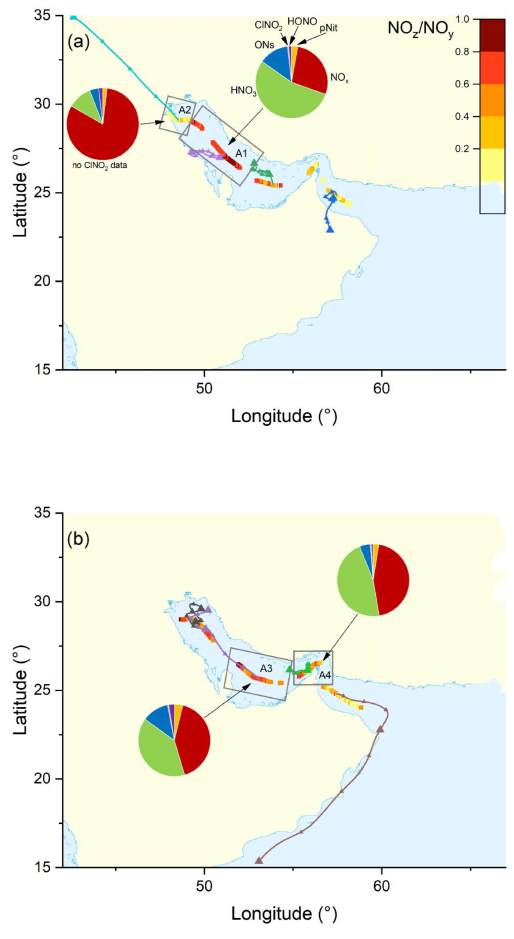
Figure 11. The NO z / NO y ratio over the Arabian Gulf during the (a) first and (b) second legs. Coloured lines are 2d back-trajectories (HYSPLIT). The pie charts indicate the components of NO y at various segments along the ship’s track (ONs = organic nitrates, pNit = particulate nitrate). HNO 3 was calculated via HNO 3 = NO z – (ONs + pNit + ClNO 2 + HONO). The colours of the pie chart segments are assigned as follows (clockwise): pNit in yellow, NO x in red, HNO 3 in green, ONs in blue, ClNO 2 in grey, and HONO in magenta.